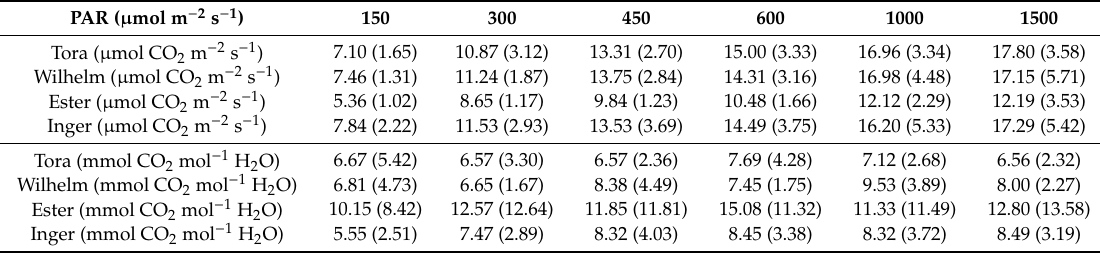
Table 7. Upper part: Net assimilation rate (A, µ mol CO 2 m − 2 s − 1 , mean ± standard deviation, n = 6–14) at di ff erent PAR values ( µ mol m − 2 s − 1 ) for the varieties. Lower part: Water use e ffi ciency (WUE,